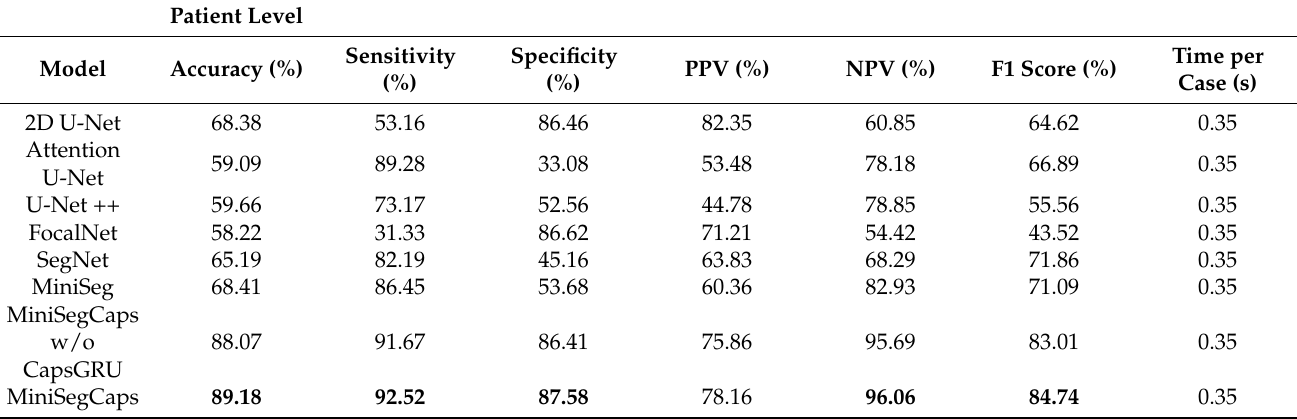
Table 8. Comparison of the patient-level performance between our method and baseline methods in prostate cancer classification on PI-RADS ≥ 4.